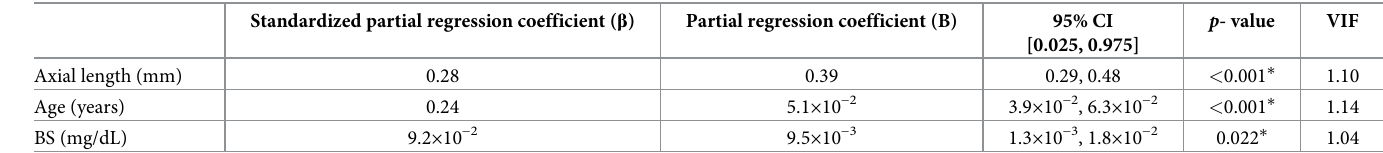
Table 3. Multivariable linear mixed effects model regression analysis between implicit times and explanatory variables. Standardized partial regression coefficient ( β